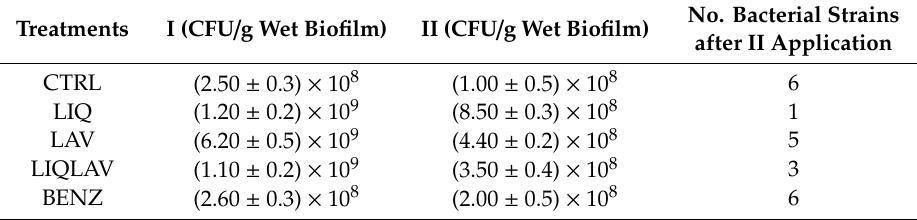
Table 2. Colony forming units (CFUs) of cultivable heterotrophic bacteria in the di ff erent treatments after first and second application. CFU as referred to gram of wet biofilm. In the last column are reported the number of bacterial strains isolated after the second application.